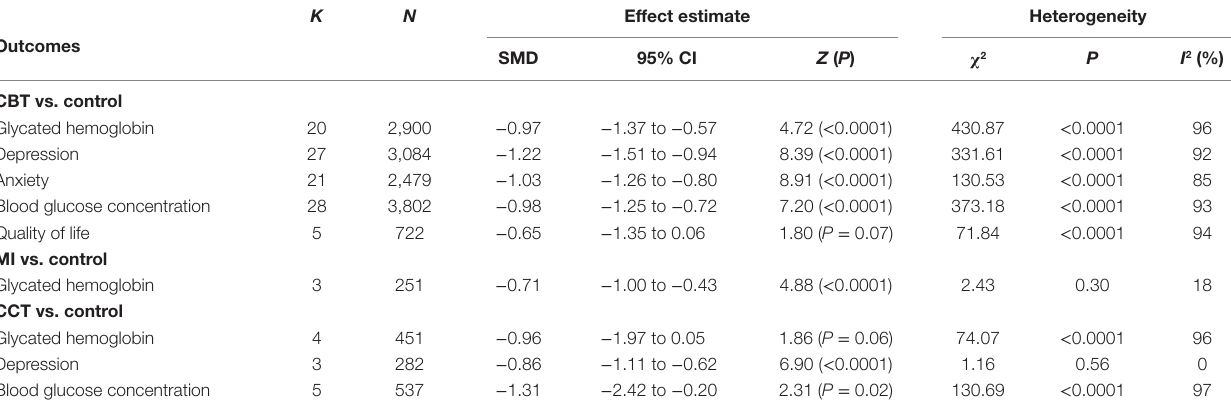
TABLe 2 | Summary of meta-analyses for psychological interventions vs. control condition.